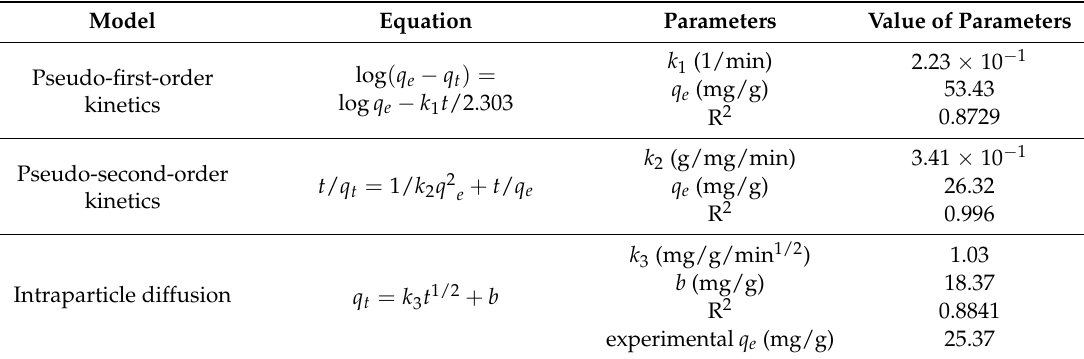
Table 9. Kinetic parameters obtained from pseudo-first-order, pseudo-second-order, and intraparticle diffusion model for the removal of Cd(II) by the nZVI/rGO composites.